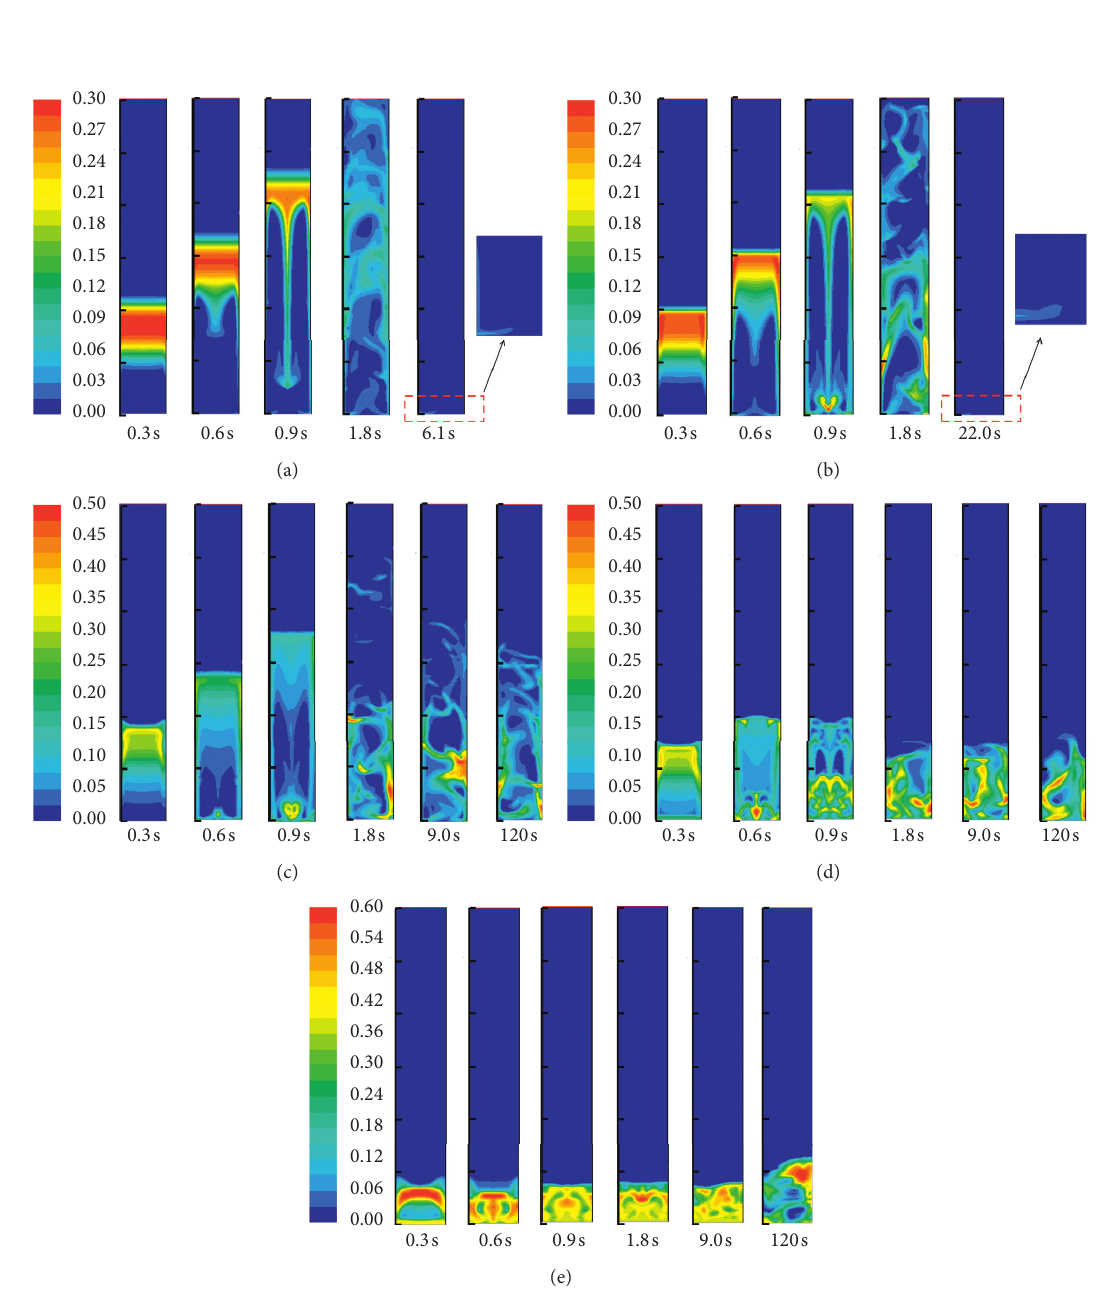
Figure 5: Volume fraction of tar mist: u � 0.70m/s and ρ � 900 kg/m 3 . (a) d � 0.10mm. (b) d � 0.20mm. (c) d � 0.30mm. (d) d � 0.50mm. (e) d �